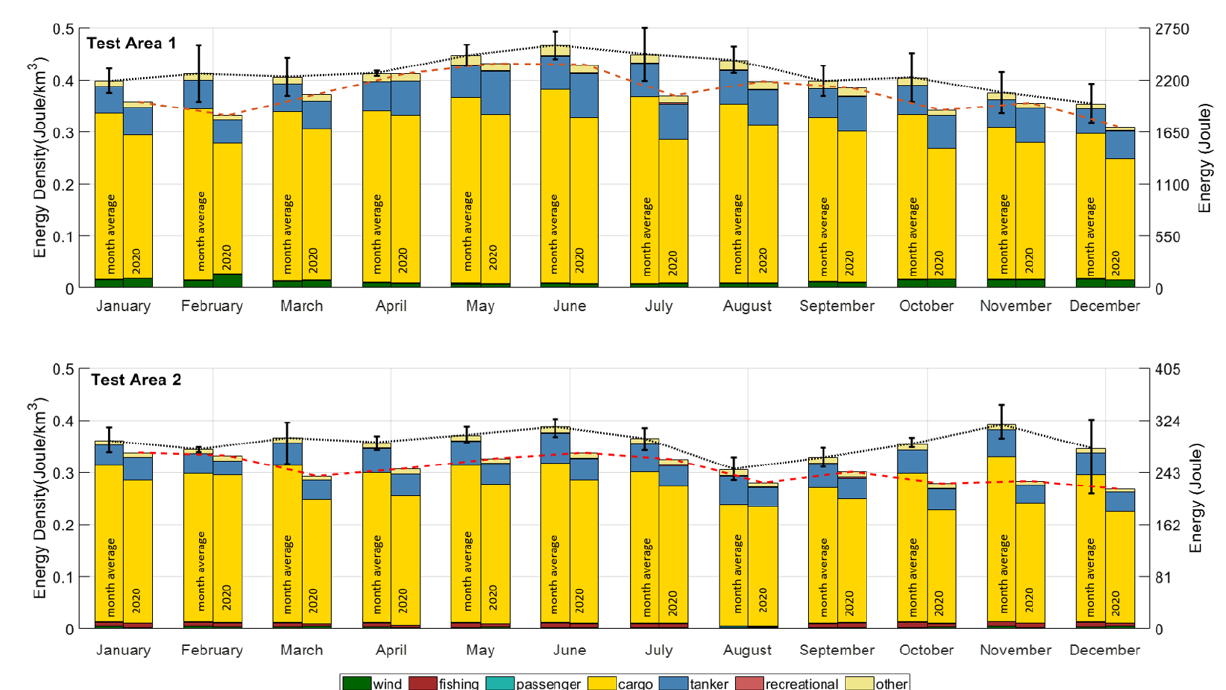
Figure 15. Comparisons for the difference in monthly averaged total acoustic energy (right y -axis) and energy density (left y -axis) for 100 Hz to 10 kHz decidecade frequency bands. The dotted black curve is based on the month-average of energies between 2017 and 2019. The vertical bars indicate the minimum and maximum energies between 2017 and 2019. The dashed-red curve is the energy density during 2020. The bars show total and individual energy densities of selected ship categories and wind for the month average (left bars) and 2020 (right